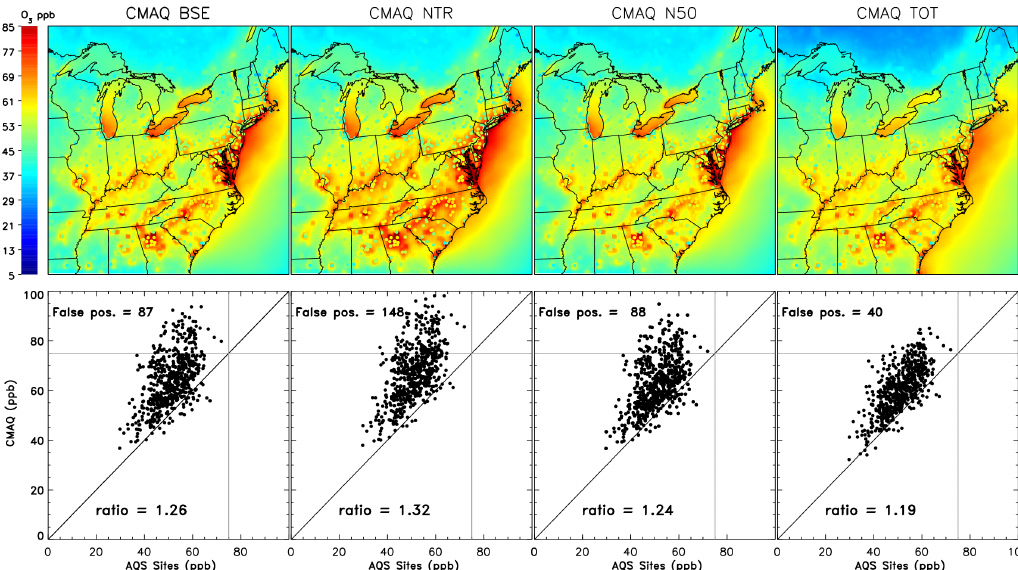
Figure 9. Average daily maximum 8h daily ozone for July and August 2007 for four model cases: CMAQ BSE (top left), CMAQ NTR (top middle left), CMAQ N50 (top middle right), and CMAQ TOT (top right) and ground based observations. Colored contours represent the CMAQ model output. Colored points denote average daily maximum 8h daily ozone from ground-based AQS sites for the same time period. Scatter plots of each CMAQ model output vs. observations are shown (bottom panels). Gray horizontal and vertical lines indicate the 75ppb ozone exceedance level. The number of times the model output is greater than 75ppb while the observations are less than 75ppb is shown (false positive). The mean ratio between CMAQ surface ozone and observations at air quality sites is indicated for each model